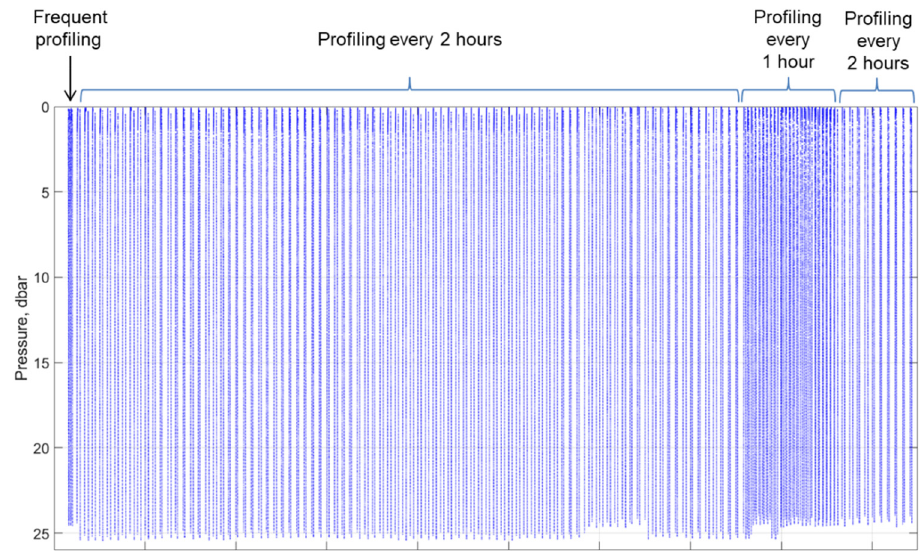
Figure 12. Time–depth plot of a typical track of the profiler. Data were acquired during the trials in the shelf area near Blue Bay in the Northeastern Black Sea in October 2019. Tick marks along the horizontal axis are placed at the Coordinated Universal Time (UTC).